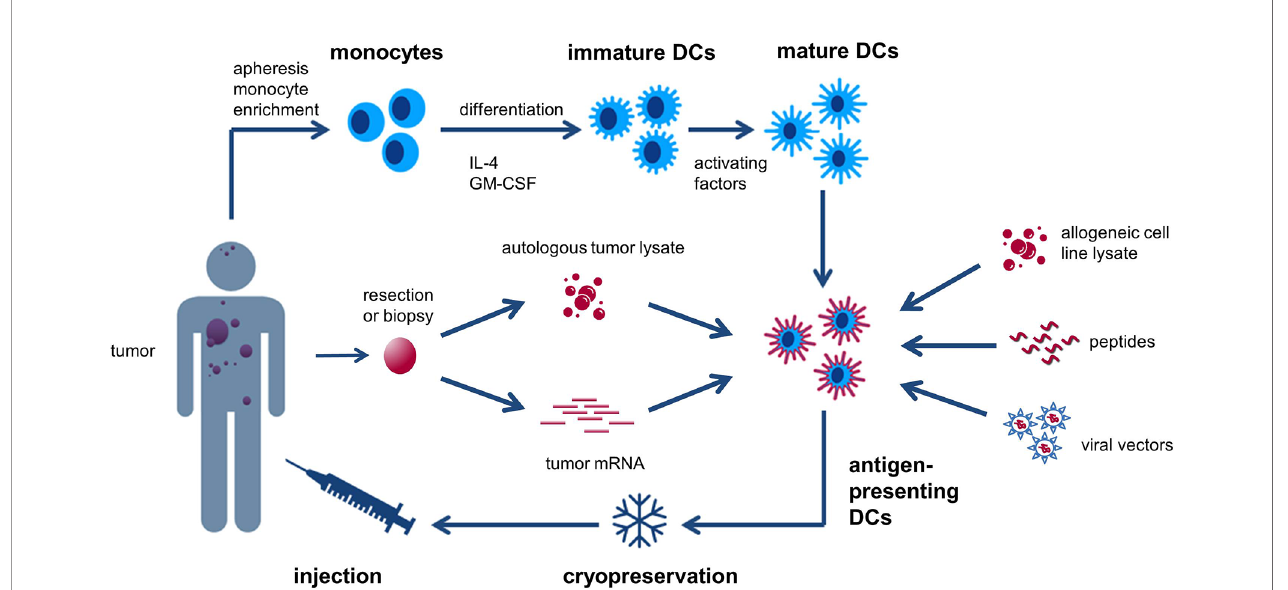
FIGURE 1 | Generic recipe of classical monocyte-derived dendritic cells (DCs). Monocytes are obtained from the patient ’ s peripheral blood and cultured with IL-4 and GM-CSF to generate immature DCs. These cells are subsequently exposed to activating factors for maturation and loaded with tumor-associated antigens (TAAs). The antigen-loaded DCs are then cryopreserved and injected back into the patient. Different sources of TAAs can be used and include cancer cell line lysate, whole tumor lysate, tumor-derived peptides, (synthetic) protein antigen(s), mRNA(s) encoding selected tumor antigen(s), autologous whole-tumor-derived mRNA, or antigens packaged within viral